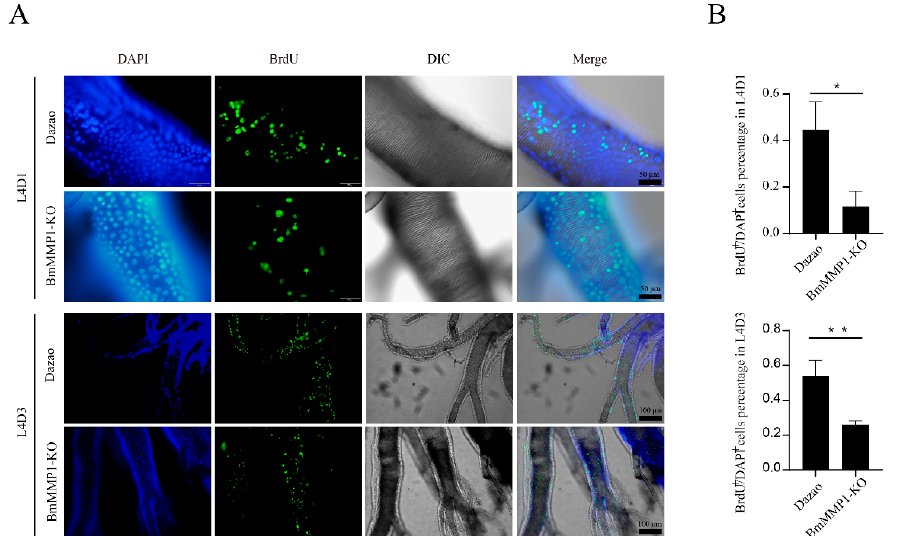
Figure 6. BmMMP1 affects the silkworm tracheal cells proliferation. ( A ) The proliferation activity of trachea cells by BrdU labeling assay in L4D1 and L4D3. DAPI (Blue) stained cell nucleus and green fluorescent signal BrdU positive cells or BrdU + cells. Different magnification was selected for the two experiments. ( B ) The ratio statistics of BrdU + cells to DAPI + cells. (*, 0.01 ≤ p < 0.05; * *, p < 0.01).